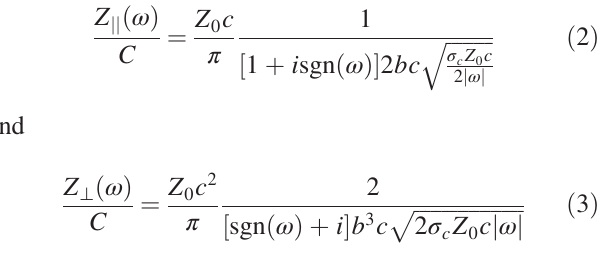
TABLE I. FCC-ee parameter list used to evaluate the beam dynamics effects of wake fields. Energy E 0 [GeV]